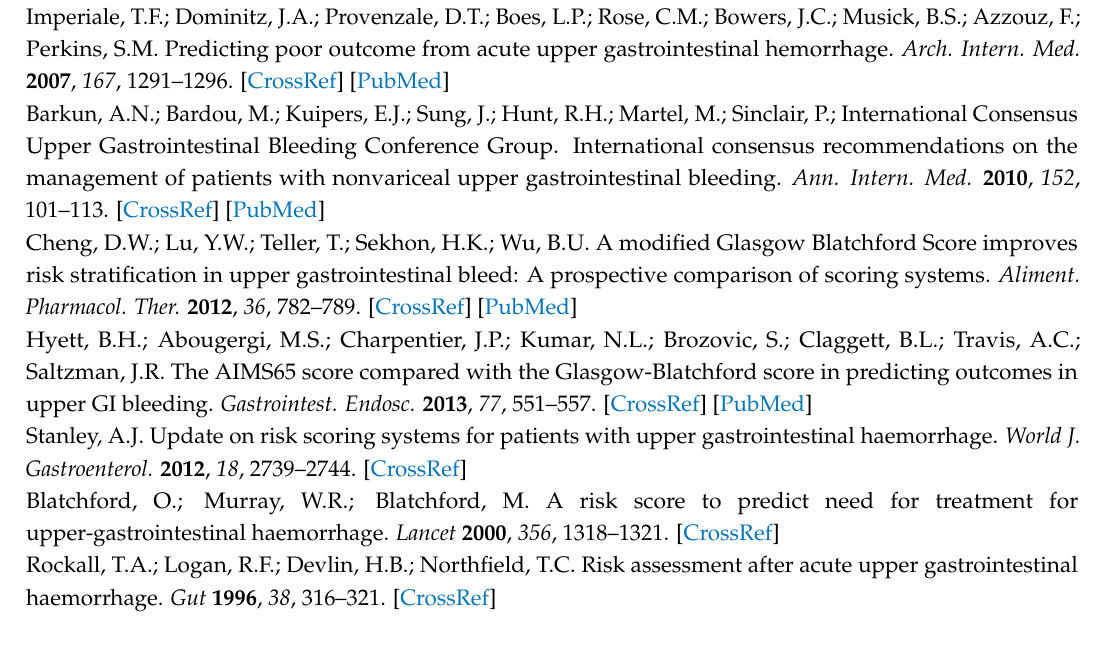
Table S1: Outcomes of the patients in the development group, Table S2: Endoscopic finding of the patients in the development group, Table S3: Test of accuracy of cutoff value for predicting need of red blood cell transfusion in the validation